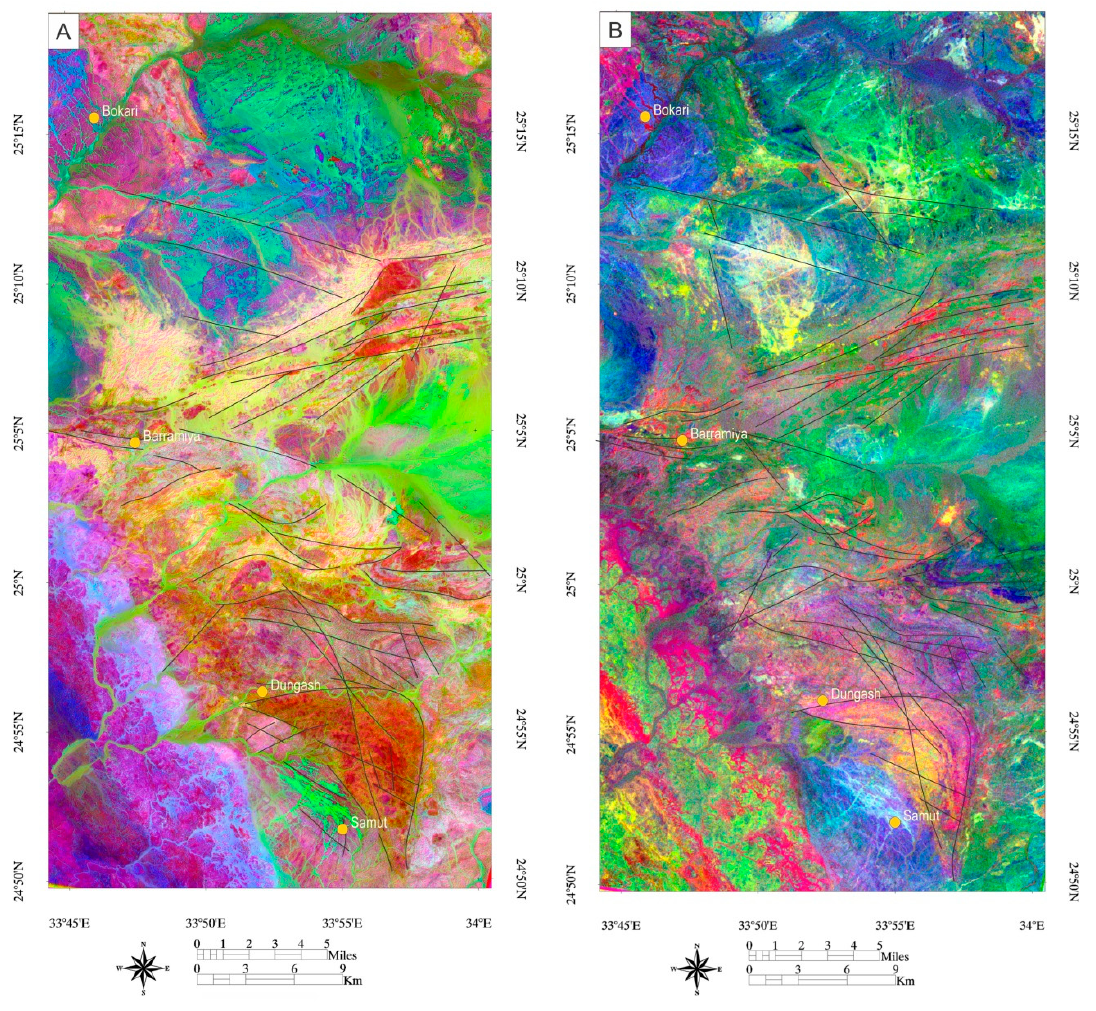
Figure 4. False-color composite, ASTER PCA images for the study area: ( A ) PC1, PC2, and PC3 (in RGB channels) shows the island arc metavolcanic / metavolcaniclastic rocks as red pixels, whereas the ophiolitic rocks and ophiolitic m é lange rocks exhibit a greenish image signature. The unconformity boundary is marked by the transition to pale blue areas (of the Nubian Sandstone) in the southwestern part of the area, ( B ) PC4, PC5, and PC6 (in RGB channels) di ff erentiates the iron oxide / hydroxide minerals (red pixels), Al–OH mineral groups (green pixels) and Fe, Mg–OH–bearing alteration minerals and CO 3 mineral groups (blue pixels). Solid black lines refer to the main lineaments (i.e., fault and shear zones) in the area. Notice that the curvilinear morphologies of the linements (transpression zones) in the central part, whereas straight lineaments (herein classified as transtension zones) prevail in the northern and extreme sourthern parts of the area.